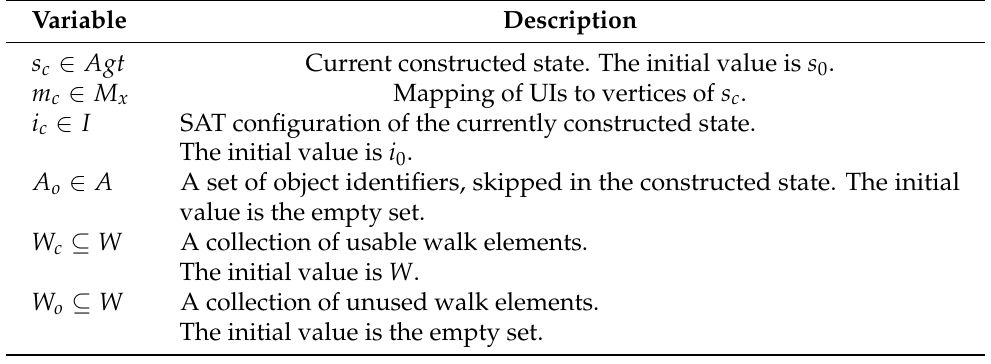
Table 8. Auxiliary variables of Phase 3 algorithm.